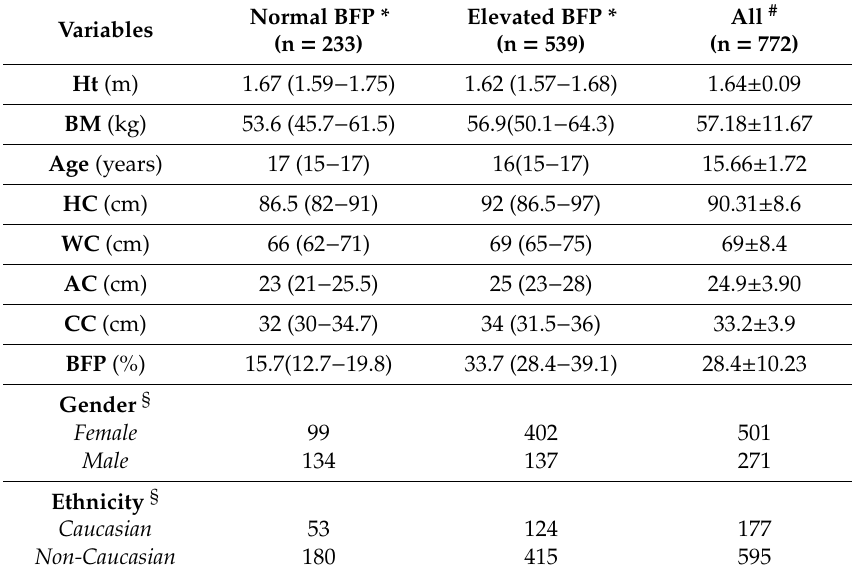
Table 2. Socio-demographic, anthropometric, and hemodynamic characteristics from the database, stratified through body fat percentage (BFP).